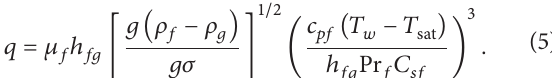
For saturation boiling region, many empirical correla- tions have been proposed in related literatures, including Jens-Lottes correlation, Rohsenow Correlation, and Corletti correlation. They are different in form and scope of applica- tion. It is necessary to find out the more suitable correlation for boiling heat transfer calculation outer PRHR HX